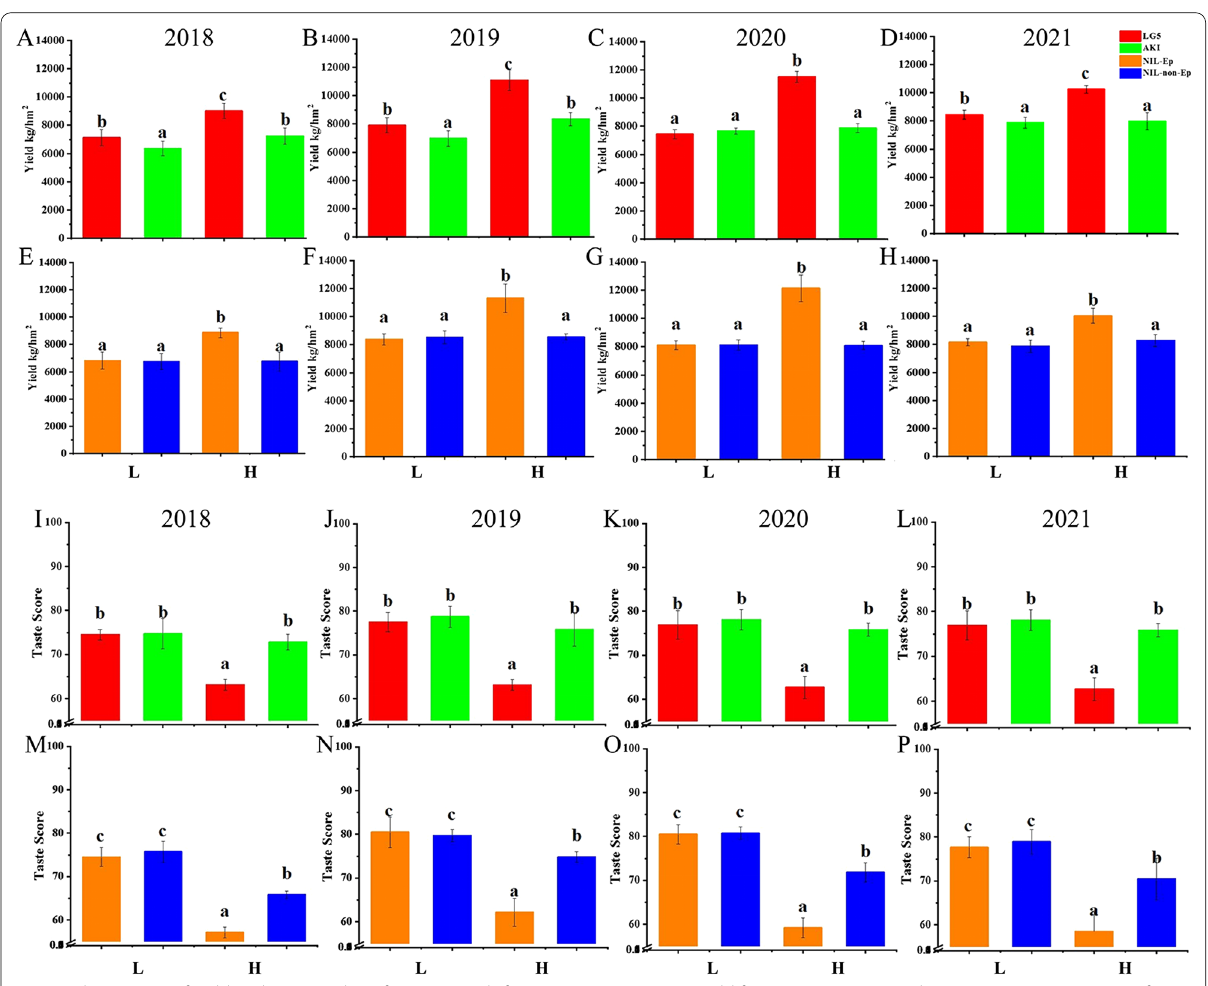
Fig. 1 Phenotypes of yield and taste quality of test meterials from 2018 to 2021. A – H Yield for LG5, AKI, NIL-Ep and NIL-non Ep. I – P Taste score for LG5, AKI, NIL-Ep and NIL-non Ep. (a), (b) Significance at the 0.05 level. L , H Low and high nitrogen treatments